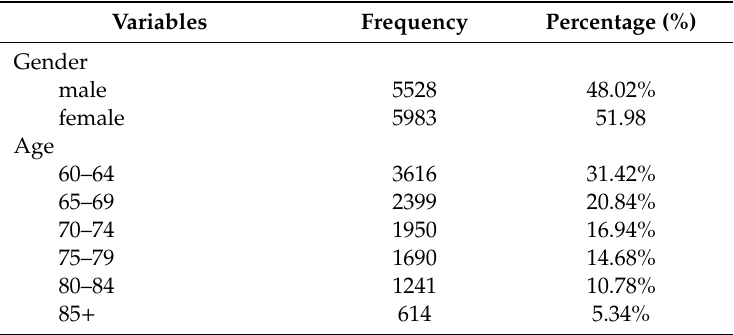
Table 1. Demographic characteristics of the